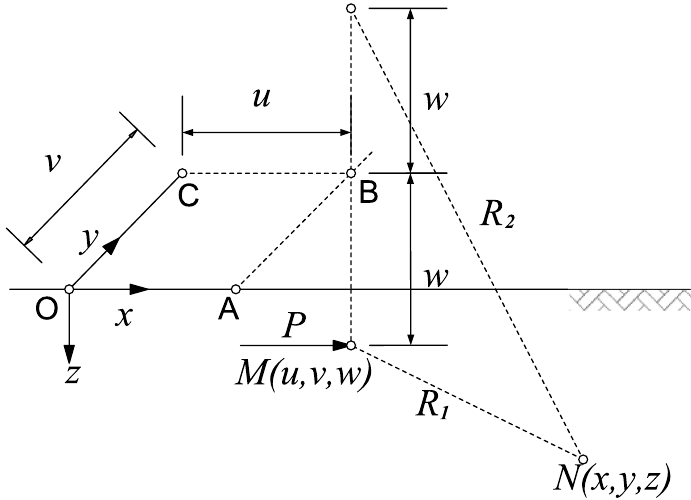
Figure 1. Coordinate system (OABC lies on the surface of the